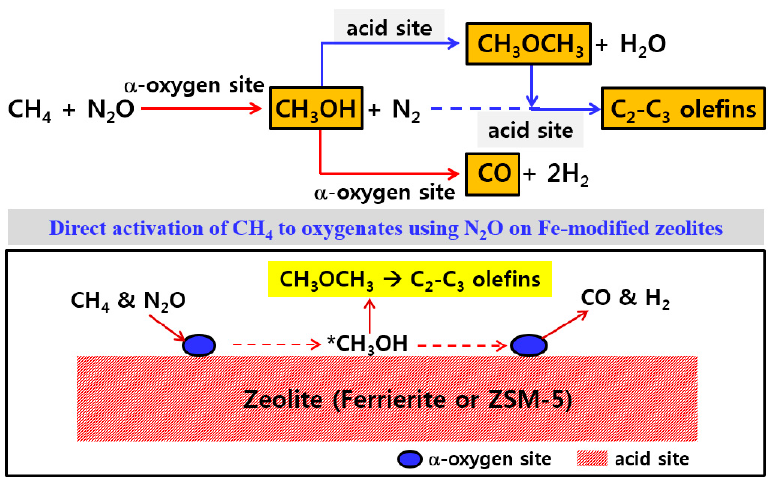
Figure 6. Scheme of direct activation of CH 4 to oxygenates using N 2 O on Fe-modified zeolites. Adapted with permission from [52]. Copyright 2017 Elsevier.